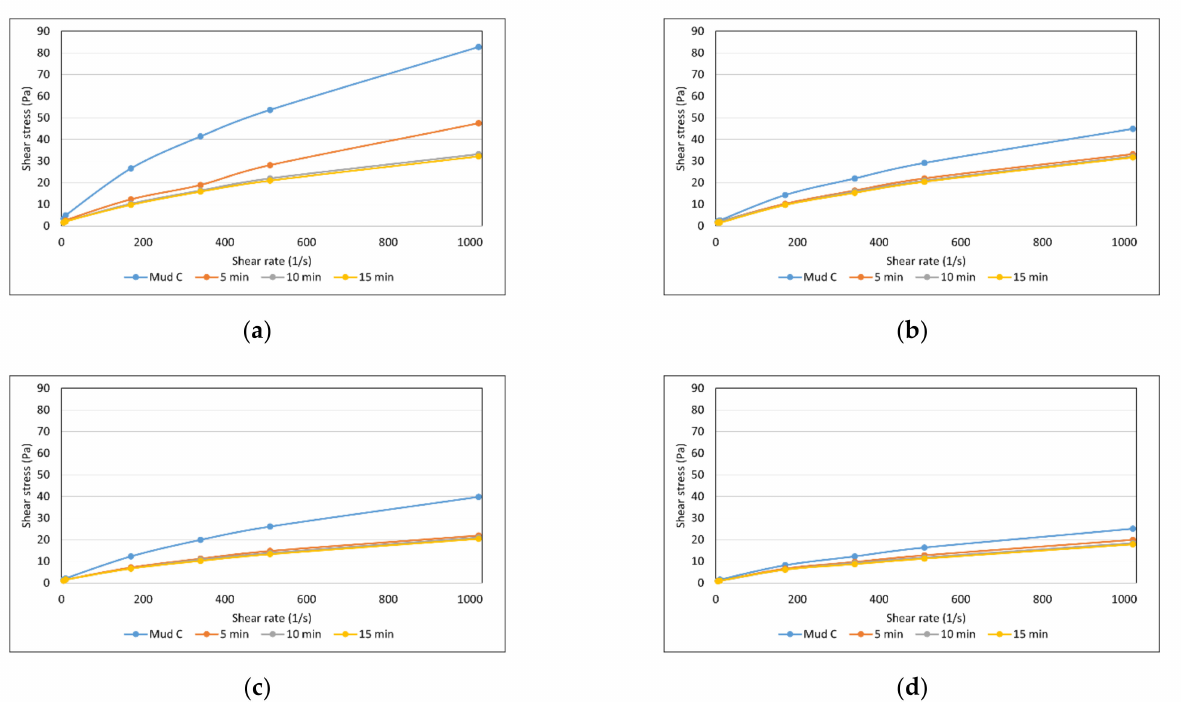
Figure 12. Flow curves of drilling mud C with the addition of 0.3% cellulase: ( a ) at 20 ◦ C, ( b ) at 40 ◦ C, ( c ) at 60 ◦ C, ( d ) at 80 ◦ C.